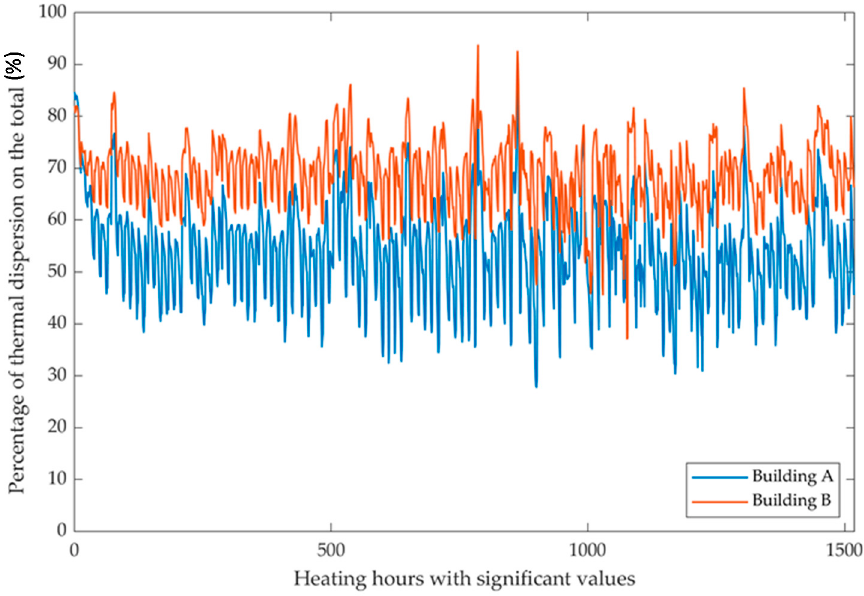
Figure 7. Thermal dispersion shares on the sum of the total energy amount connected to thermal dispersions and ventilation losses.